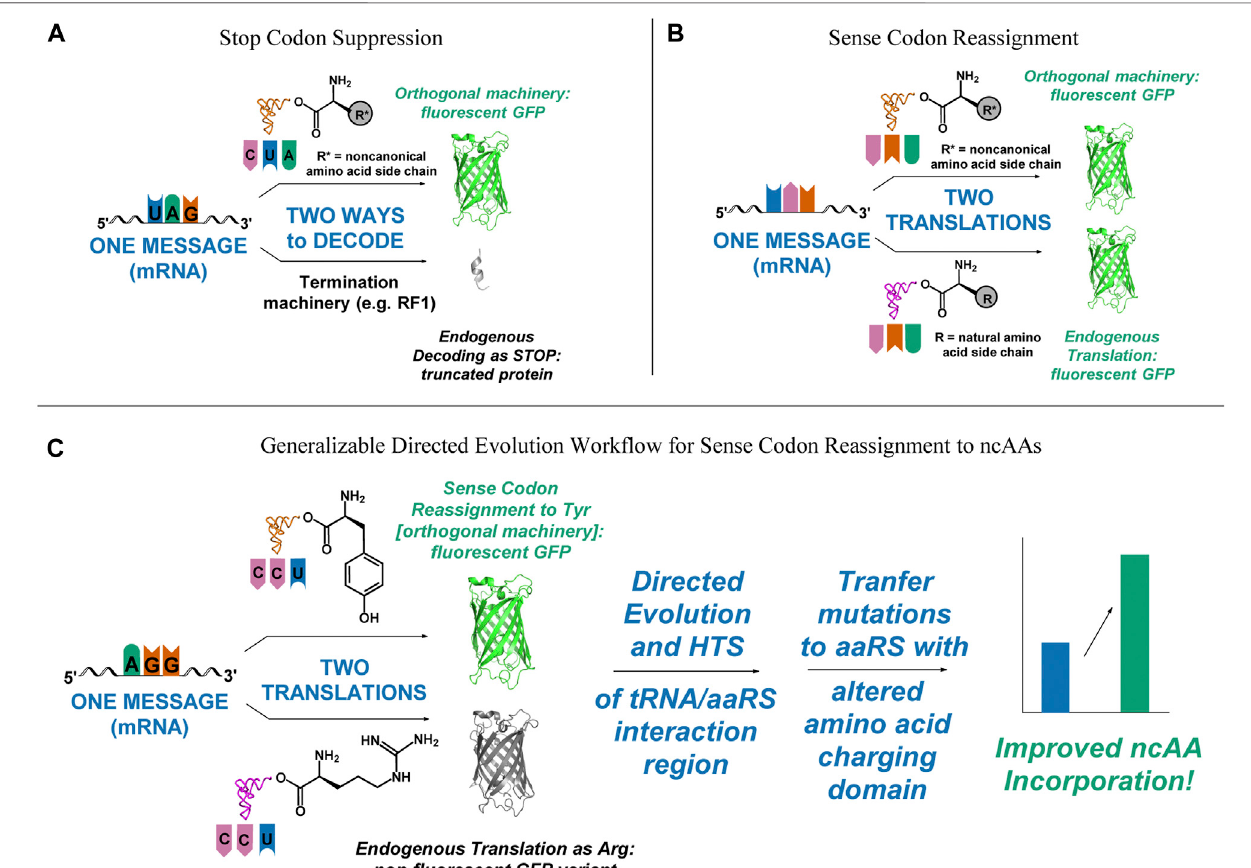
FIGURE 1 | Visual representation of outcomes of successful and unsuccessful selection schemes, depicting the need for a fast, functional screen for improving sense codon reassignment. (A) In stop codon suppression, only successful incorporation of the ncAA leads to functional full-length protein. Missed incorporations lead to truncated products. (B) In sense codon reassignment, incorporation of either the desired ncAA or a canonical amino acid lead to full-length, functional protein. (C) A directed evolution pathway that incorporates improvement of sense codon reassignment using a readily screenable reporter, followed by transplantation of the mutationsthatgaverisetotheimprovedreassignmentef fi ciencyontoanorthogonalpairthatincorporatesancAAwouldloweroneofthemajorbarrierstoutilizingsense codon reassignment for expansion of the genetic code to 22 amino acids and beyond.